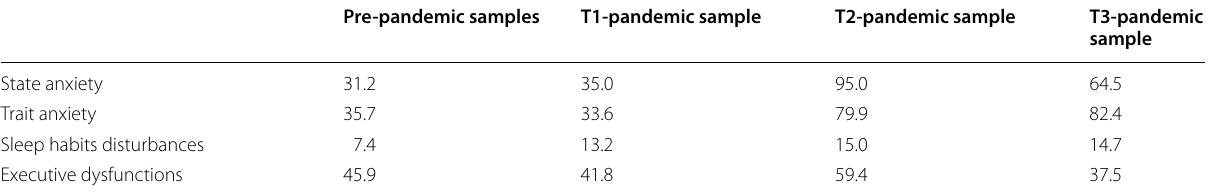
Table 2 Means for state/trait anxiety, sleep habits and executive functioning of pre‑pandemic samples and COVID‑19‑pandemic samples assessed at T1, T2 and T3